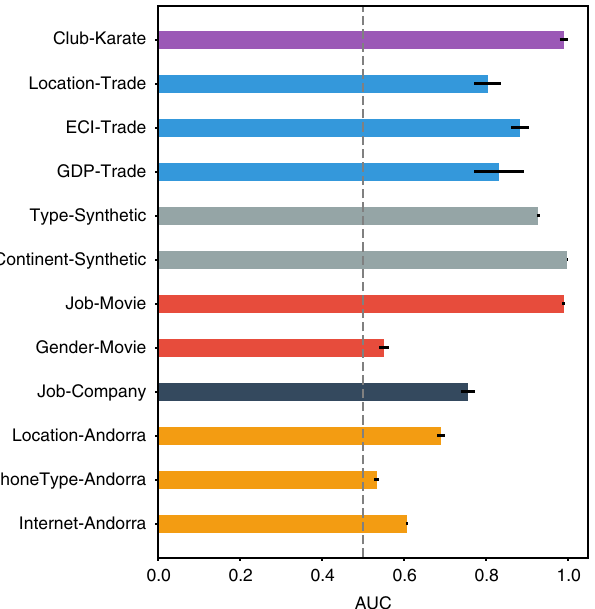
Fig. 2 Prediction performance of the learned endowments. We use support vector machine as the classi fi er. The baseline, random guess algorithm, is indicated by the dashed line. Error bars represent the standard errors for the average AUCs in fi ve random splitting of training-test